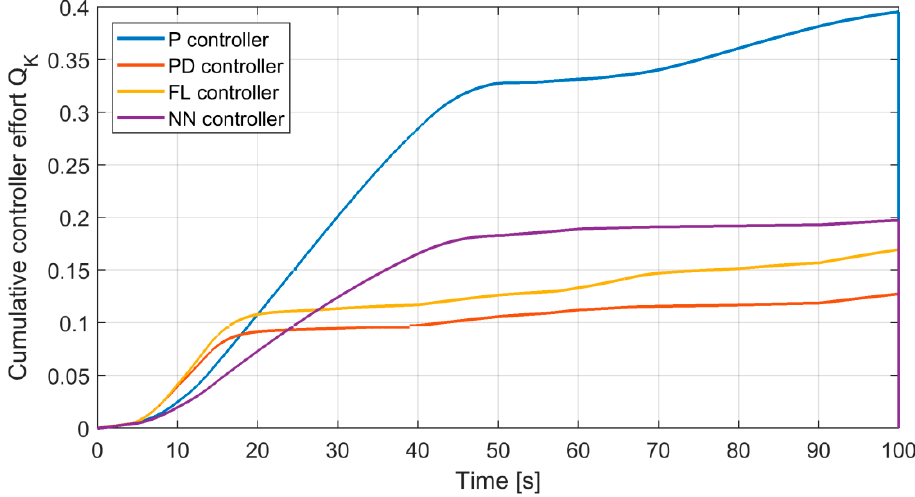
Figure 17. The cumulative effort of the four investigated controllers in time horizon T = 100 s.